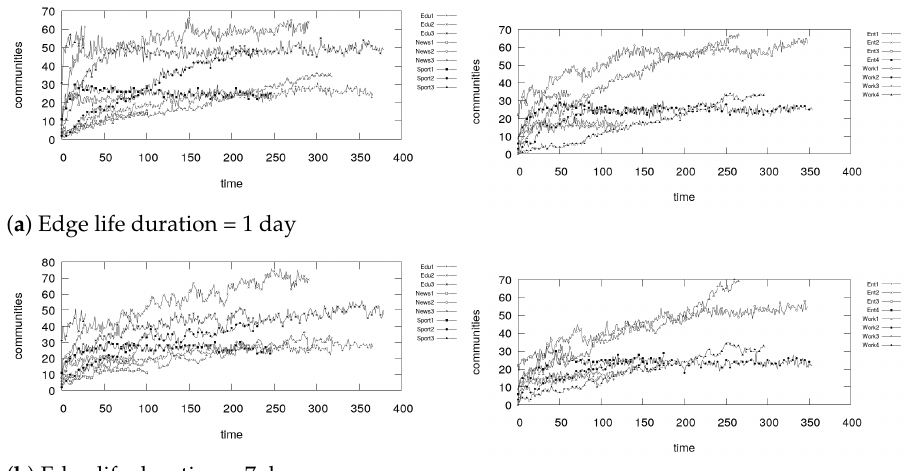
Figure 7. Number of communities detected by